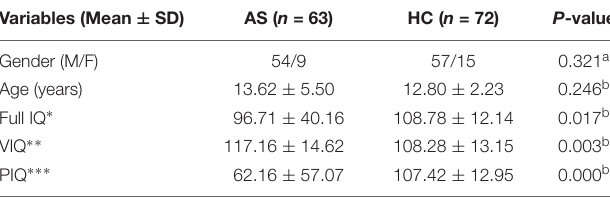
Values are mean ± SD. a The p-value is obtained by the chi square test. b The p-value is obtained by a double sample t-test. ∗ indicates that the scores of eight subjects are missing. ∗∗ indicates that the scores of 32 subjects are missing. ∗∗∗ indicates that the scores of 28 subjects are missing.